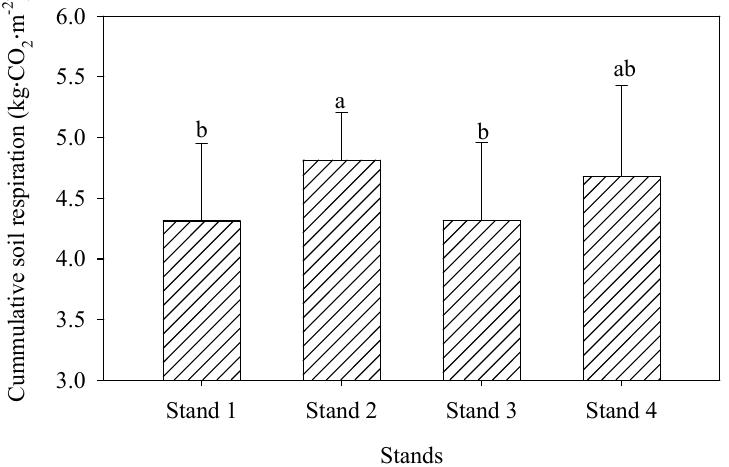
error bar was the mean value of three plots in each stand (mean±SD, n =3). bar was the mean value of three plots in each stand (mean ± SD, n = 3).